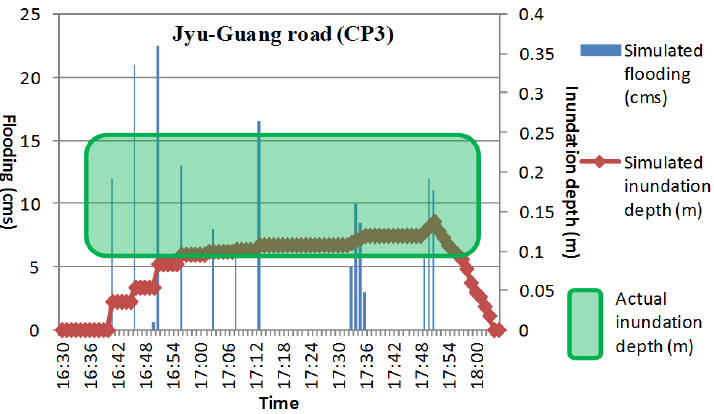
Figure 6. Calibration results of stormwater runoff management model (SWMM).